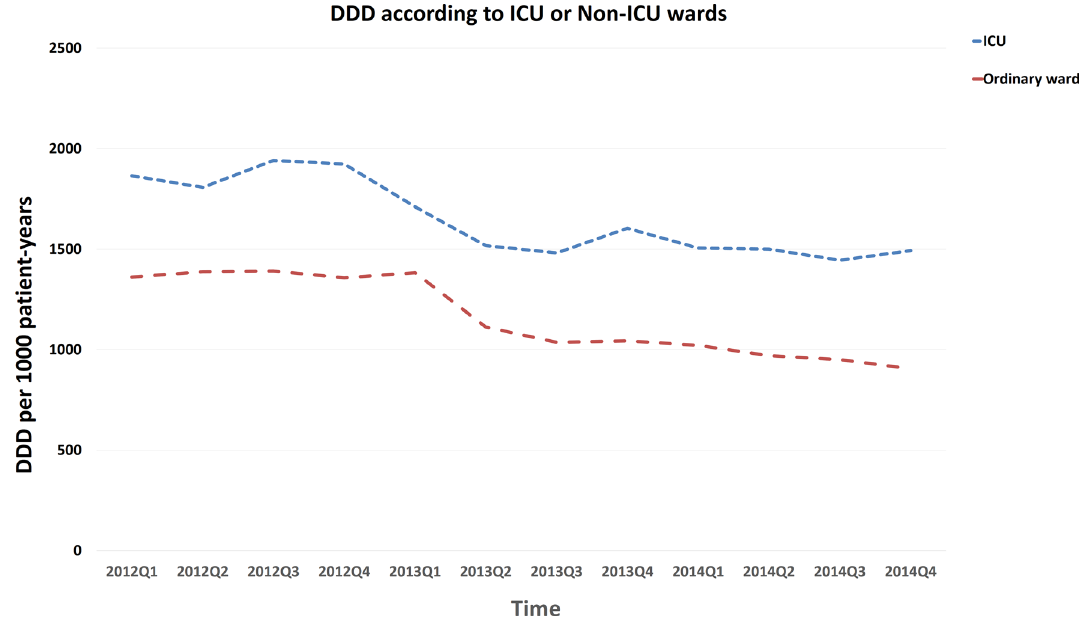
Figure 5. Trends of antibiotic consumption according to intensive care unit (ICU) and non-ICU ward. Both ICU and non-ICU wards showed a decreased trend of antibiotic consumption through the study period.